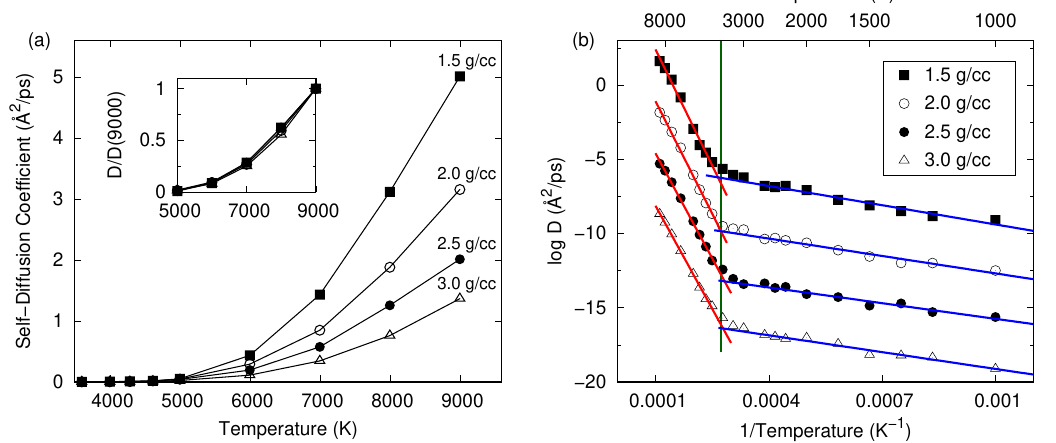
Figure 4. ( a ) Self-diffusion coefficient, D , as a function of temperature at 1.5, 2.0, 2.5 and 3.0 g/cc using the Tersoff potential. Inset shows the data scaled by the value of D at 9000 K. ( b ) Same data plotted in an Arrhenius manner. Data at 2.0, 2.5 and 3.0 g/cc is offset vertically as described in the